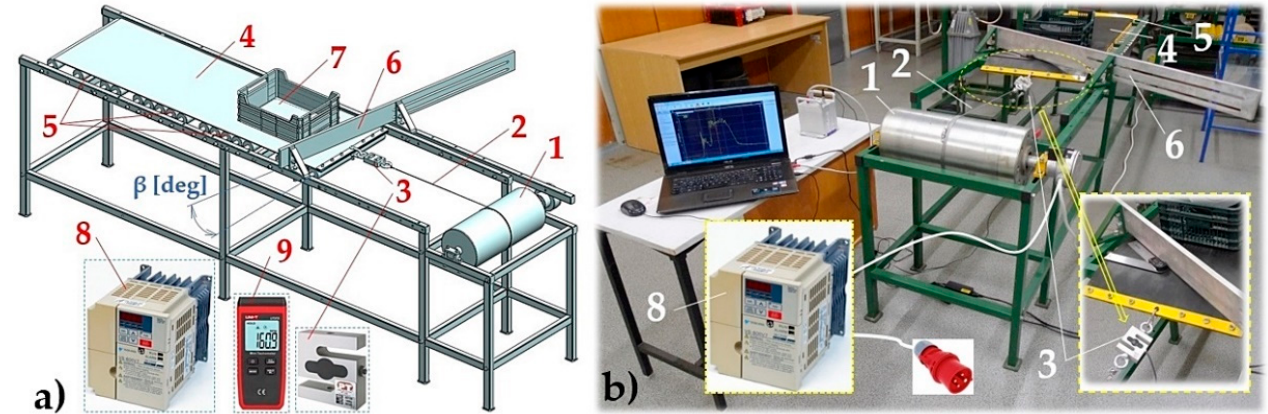
Figure 2. ( a ) 3D model of the laboratory device, used for experimental resistance measurements generated by a diagonal plough, created in the SolidWorks 2012 × 64 SP5.0 environment; ( b ) building the laboratory machine: 1—drive drum; 2—steel rope; 3—load cell; 4—conveyor belt; 5—conveyor idlers; 6—diagonal scraper plough; 7—plastic crate; 8—frequency converter; 9—tachometer.